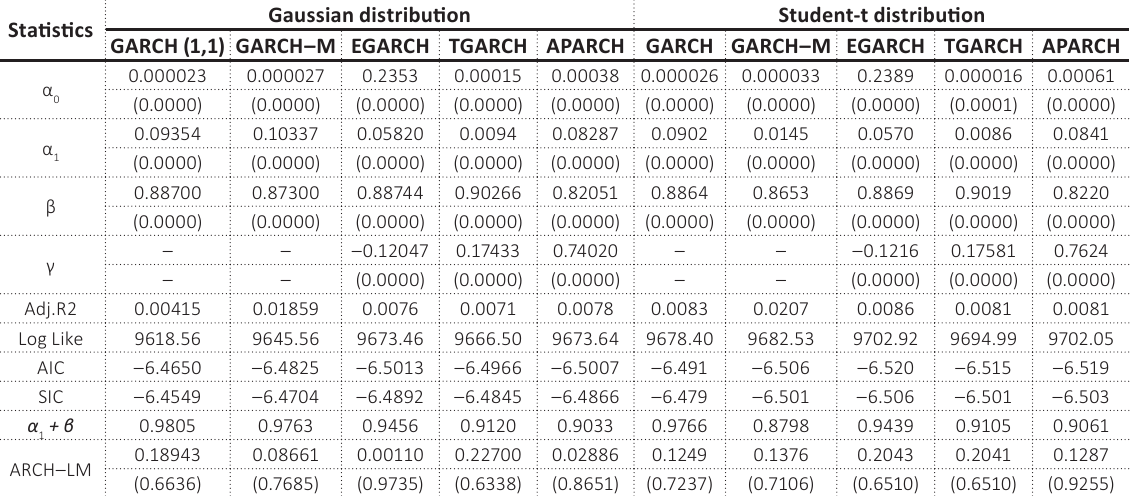
Table 9. Estimation result of GARCH models: